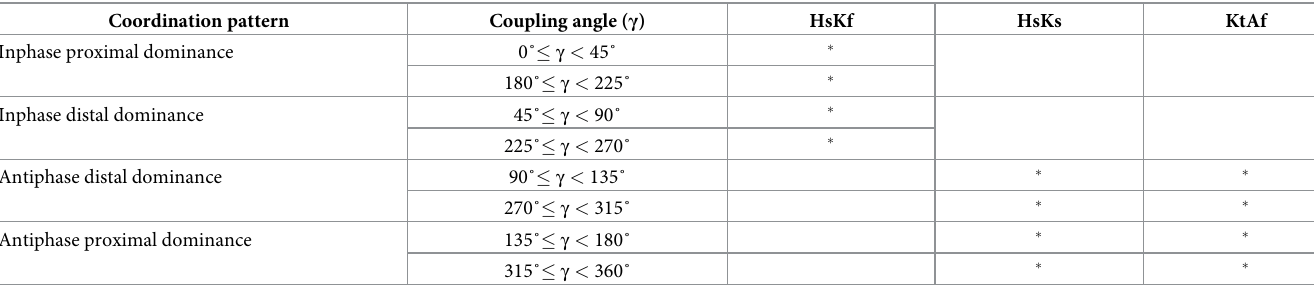
The abbreviations used are as follows: D: distal joint, P: proximal joint, � indicates that motion is mechanically